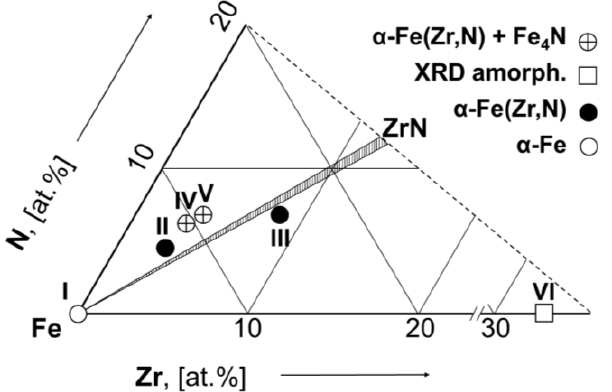
Figure 2. The compositions of the as-deposited films applied to the concentration triangle of the equilibrium Fe-Zr-N ternary system (scheme). The dashed area corresponds to the two-phase (αFe + ZrN) area.